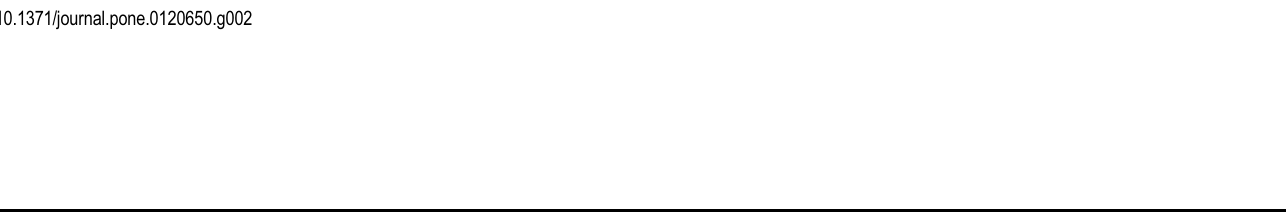
PLOS ONE | DOI:10.1371/journal.pone.0120650 March 23,